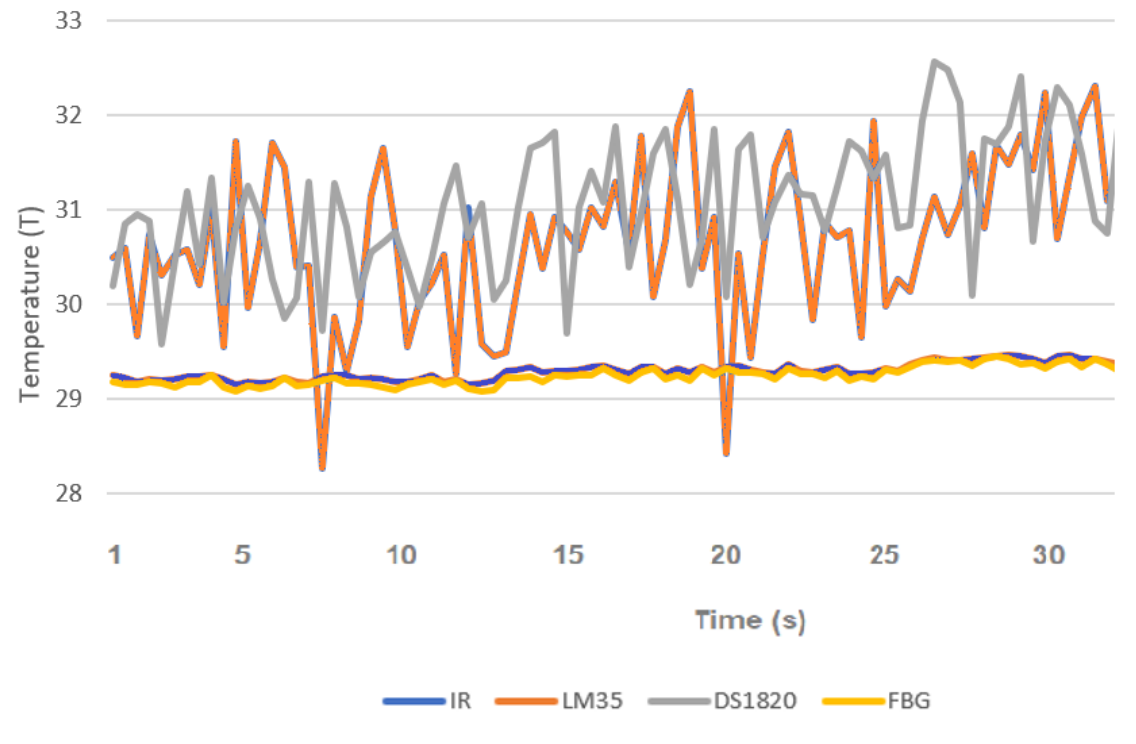
Figure 9. Temperature reading trends of FBG, LM35, and DS18B20 sensors in battery discharging test case.